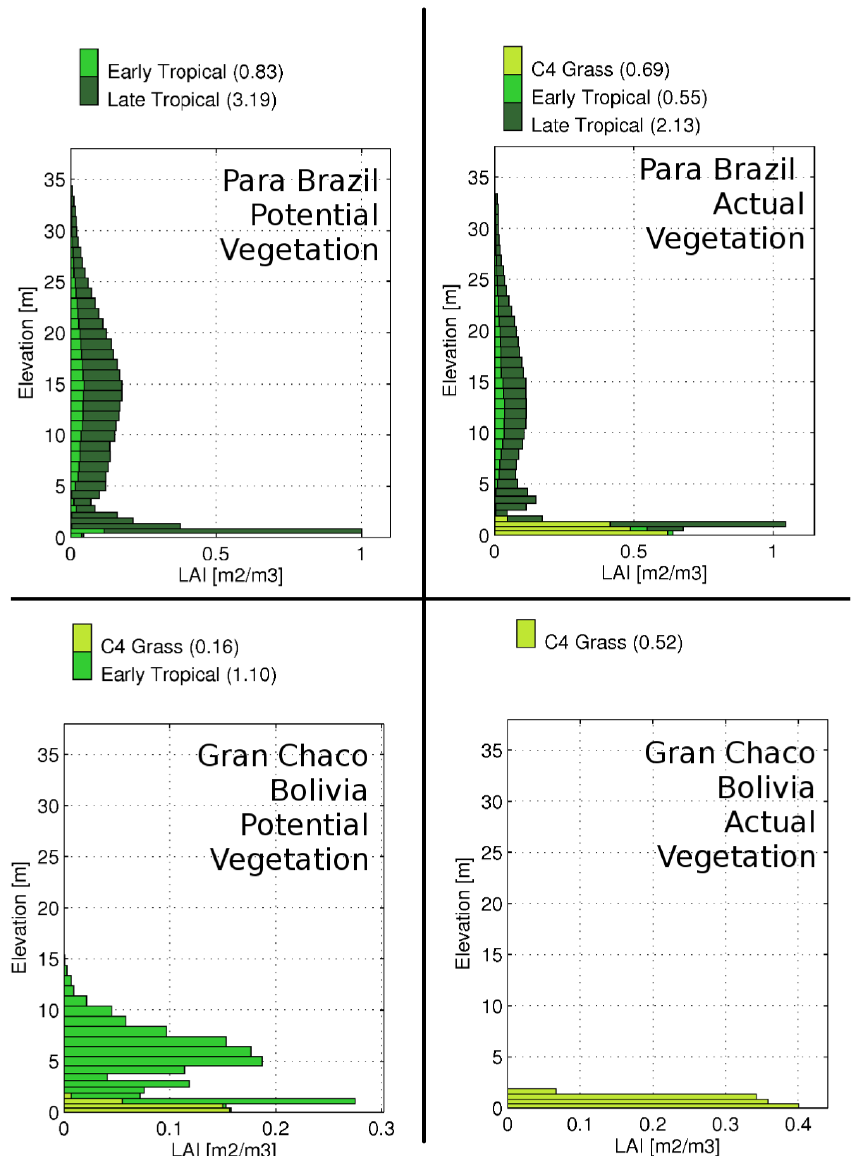
Figure 7. Mean vertical leaf area index profiles (m 2 m − 3 ) estimated by the ecosystem demography model 2 at the two focus areas. Vertically integrated leaf area index (m 2 m − 2 ) per each represented functional type of plant is shown in the key above each